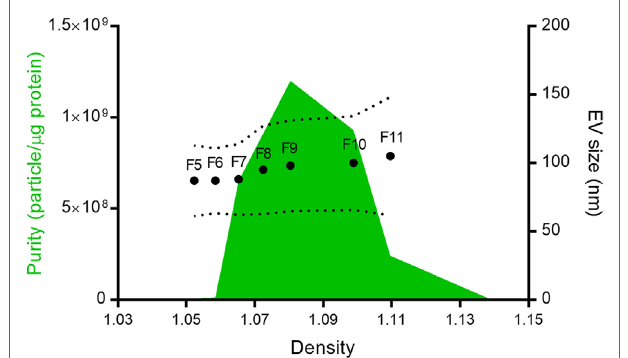
FigUre 1 | Nippostrongylus brasiliensis secreted extracellular vesicles (EVs). Mean particle size (dots), size range (dotted line), and purity (green area) of the different fractions isolated after Optiprep ® density gradient centrifugation. Despite protein being detected in all fractions, only vesicles from fractions 5–11 (F5–F11) could be quantified by tunable resistive pulse sensing. The purity of the different fractions was calculated according to Webber and Clayton (35).